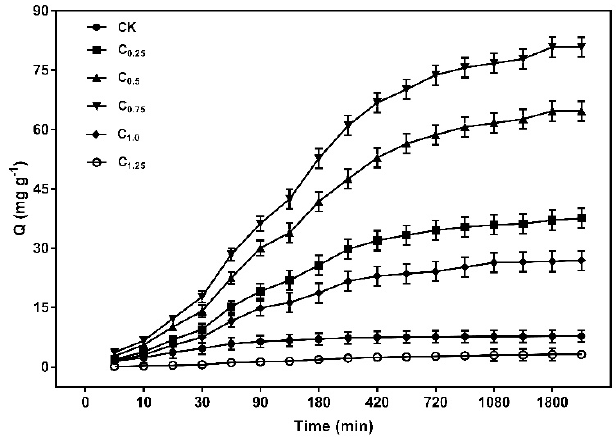
Figure 9. Kinetics adsorption scatterplot of the cystamine-modified biochars for Cd (II).